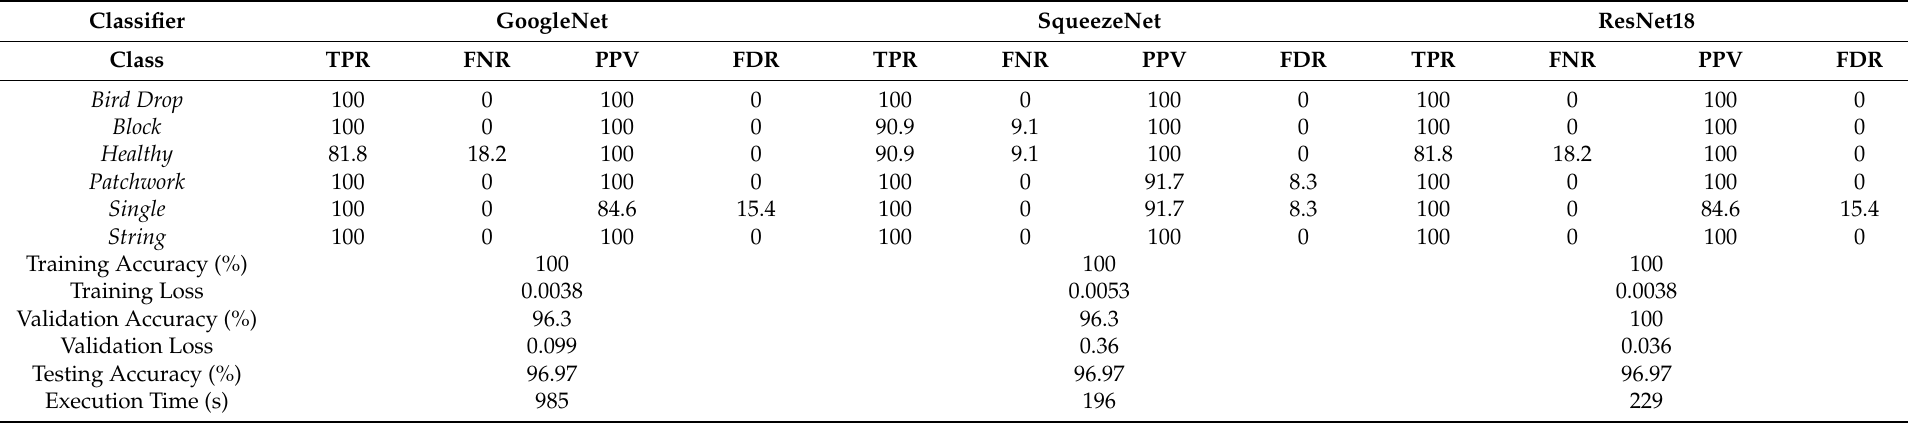
Table 4. Transfer-learned deep neural networks for PV panels condition monitoring.